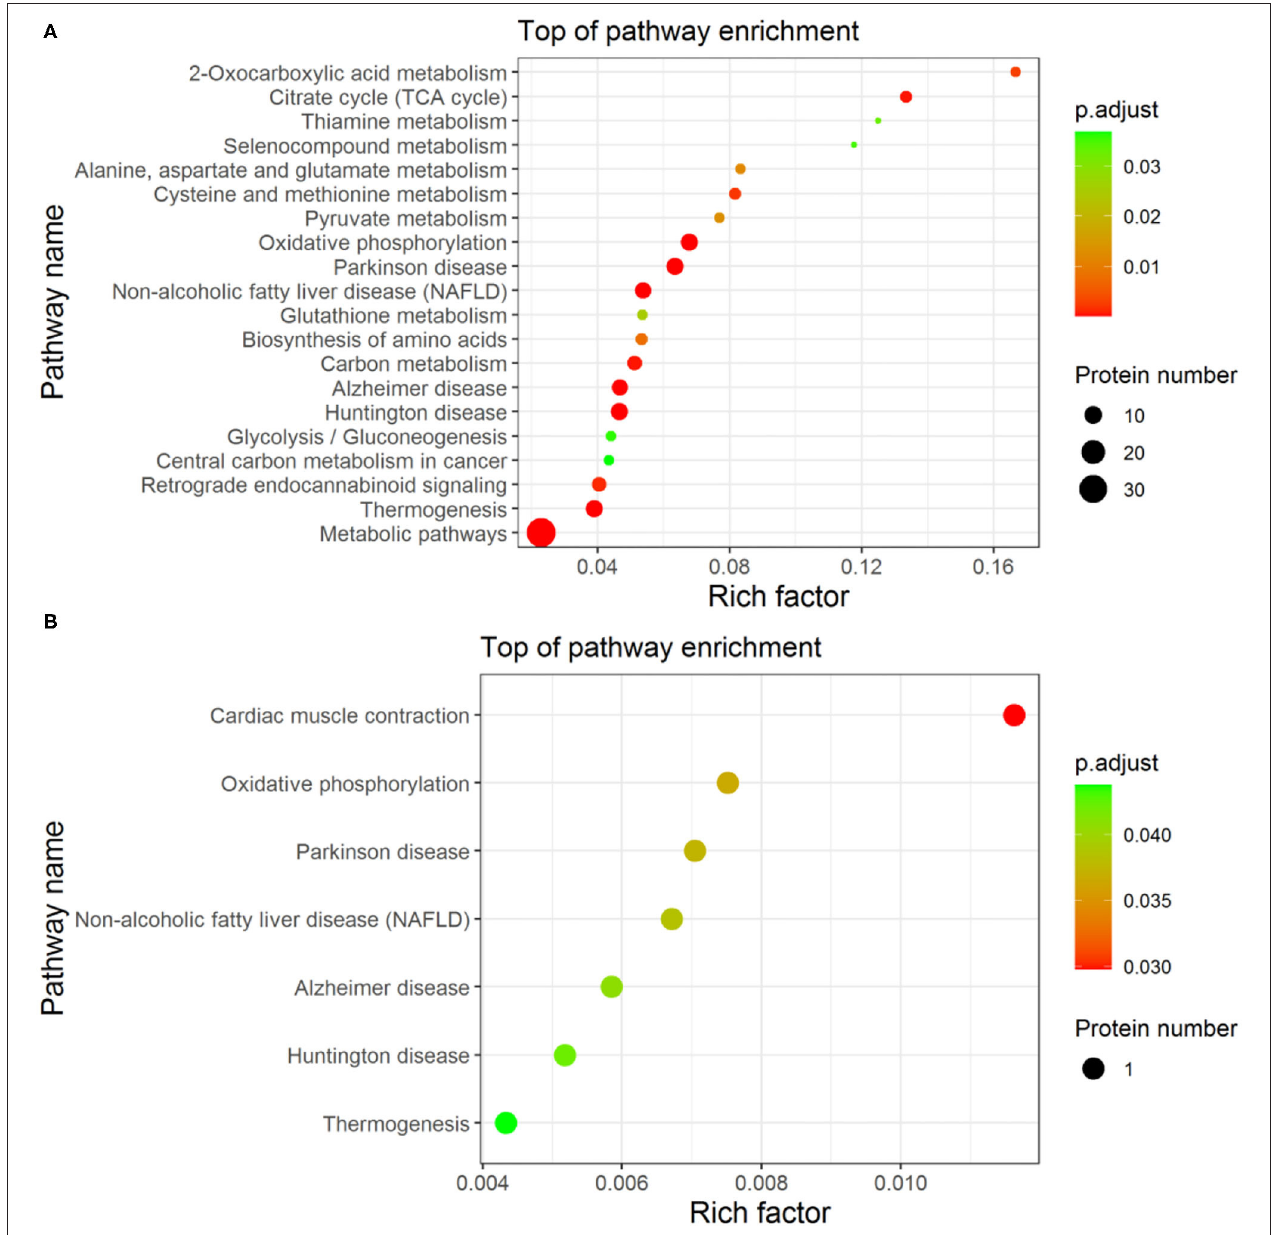
FIGURE 4 | The enrichment analysis-based clustering of the KEGG pathway. (A) between Fresh and Cryo–AFP groups; (B) between Cryo–AFP and Cryo + AFP groups.